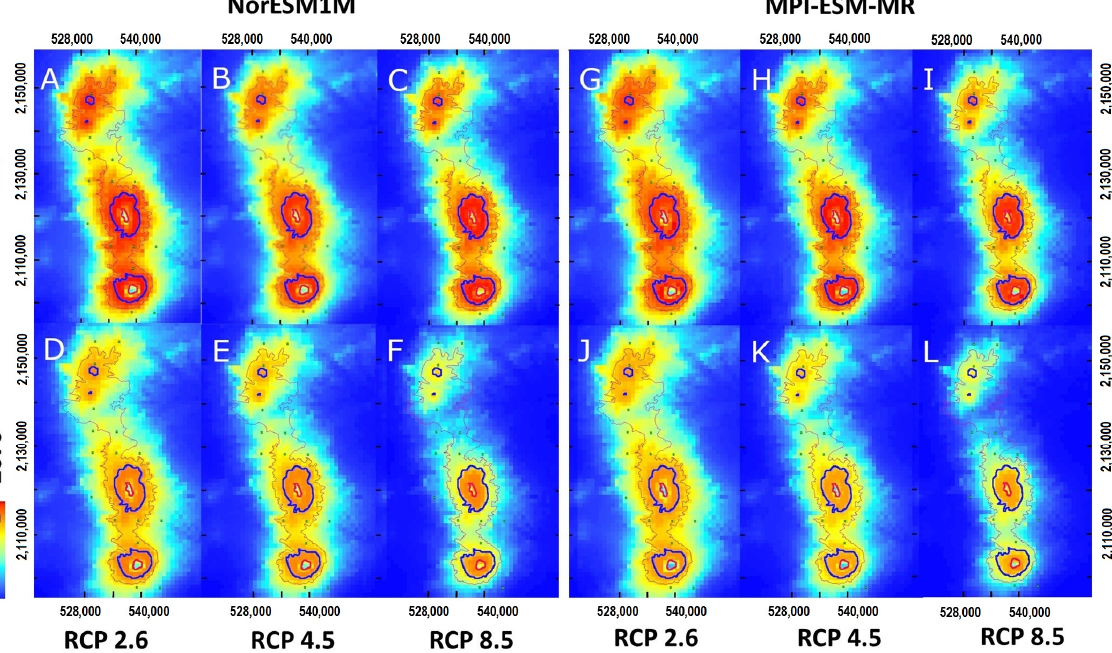
Figure 5. Izta-Popó’s habitat suitability of Pinus hartwegii as projected by model 5 (Table 4) for 2050 (upper file) and 2070 (lower file), and future climatic conditions as modeled by NorESM1-M ( A – F ) and MPI-ESM-MR ( G – L ). Three different CO 2 Concentration pathways (RCP) were used: RCP 2.6. ( A , D , G , L ); RCP 4.5 ( B , E , H , K ); and RCP 8.5 ( C , F , I , L ). Map lines represent 3000 (brown-fine line), 4000 (blue), and 4800 (red) m a.s.l.